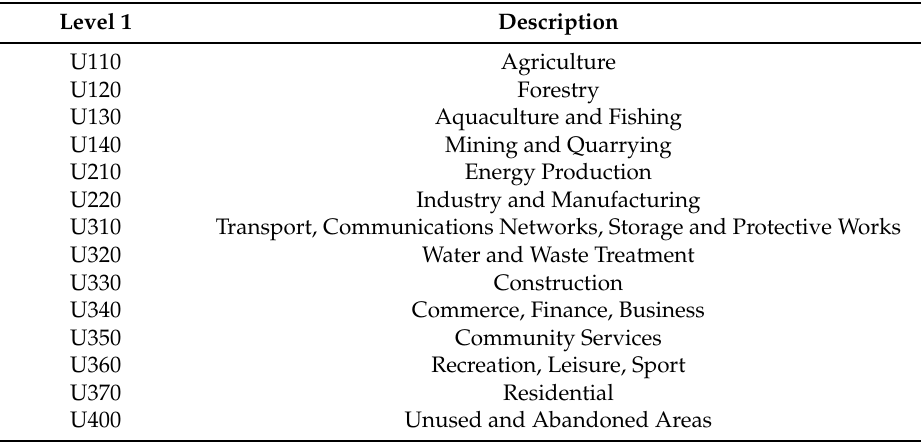
Table 2. LUCAS land use classification